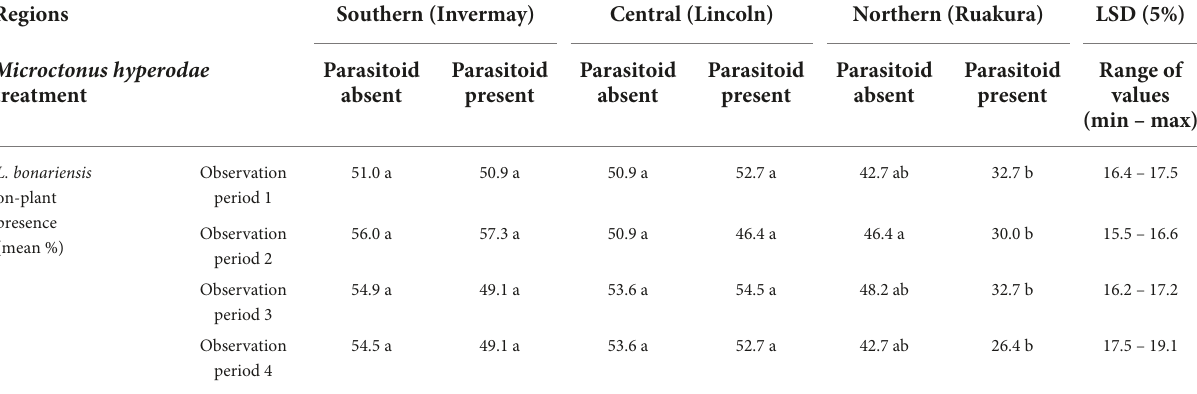
TABLE 1 Behavioural experiment